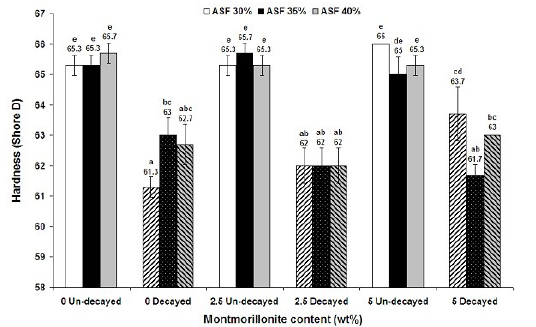
Figure 1. The average and standard errors for the weight loss measurements of the composites. Results with different letters are significantly different. The same letters in each column indicate that there is no statistical difference (p< 0.05) among the composite groups.